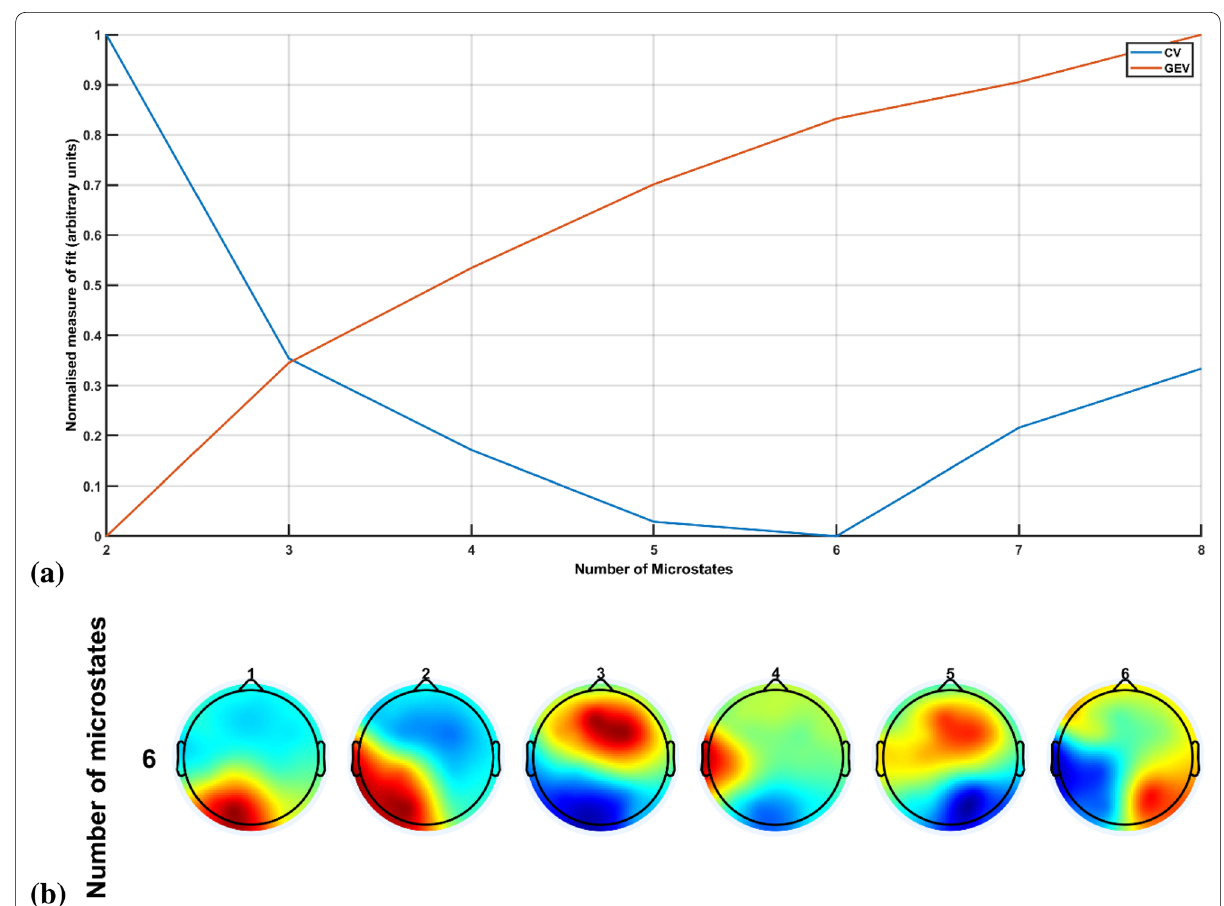
Fig. 4 a Measures of fit plotted for the different microstate segmentations based on the global explained variance (GEV) and the cross-validation criterion (CV). b Selected six microstate prototypes based on the GEV and the CV criterion that are sorted in decreasing